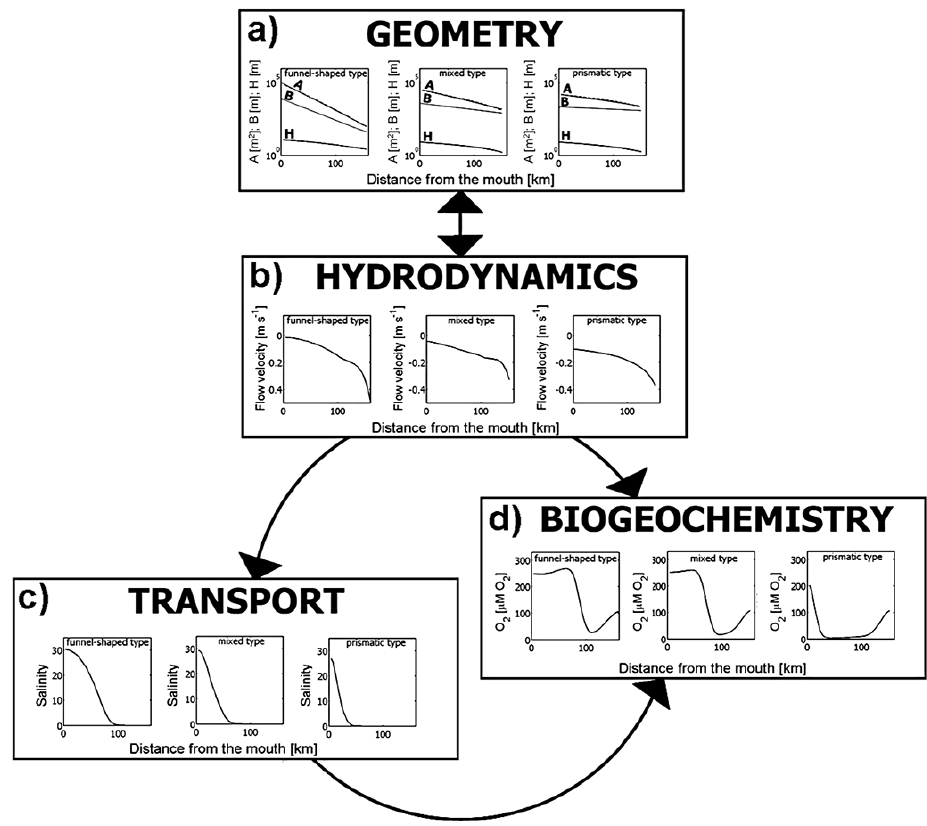
Figure 3. The C-GEM concept. Each estuarine type responds in a typical manner to the interdependence between geometry and hydrody- namics and to the first-order control of hydrodynamics on estuarine biogeochemistry. Longitudinal distribution of: (a) A = cross-section area in m 2 ; B = width in m; H = water depth in m; (b) flow velocity in ms − 1 ; (c) salinity; (d) O 2 concentration in µMO 2 .